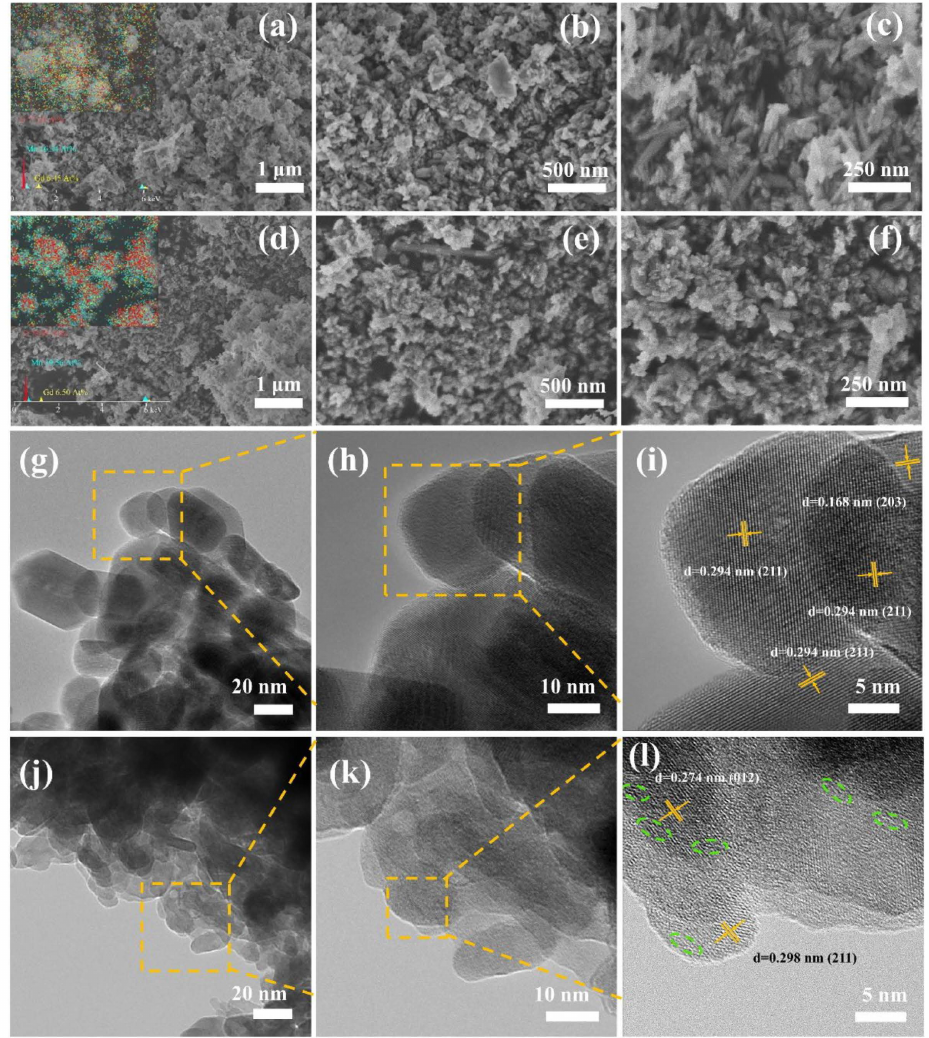
Figure 2. SEM images of GMO ( a – c ) and GMO-H ( d – f ), and TEM images of GMO ( g – i ) and GMO-H ( j – l ). Table 2. BET results, H 2 consumption, O 2 relative consumption, and Benzene conversions for